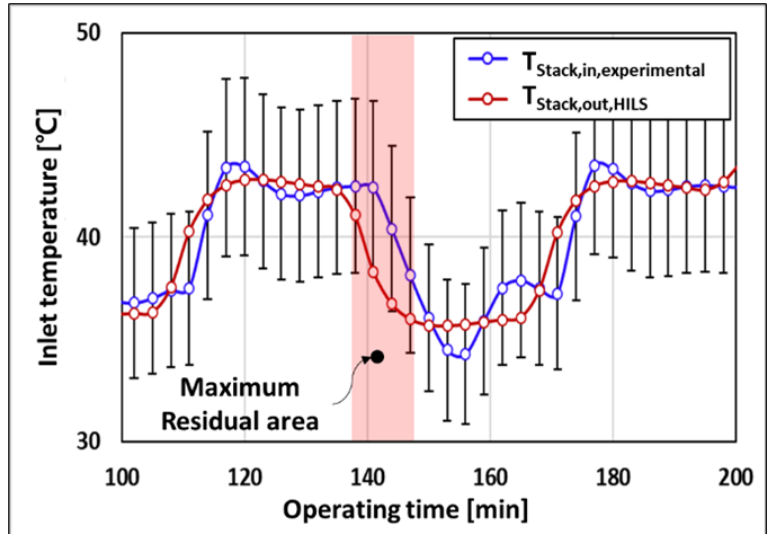
Figure 11. Temperature transient responses of stack inlet.